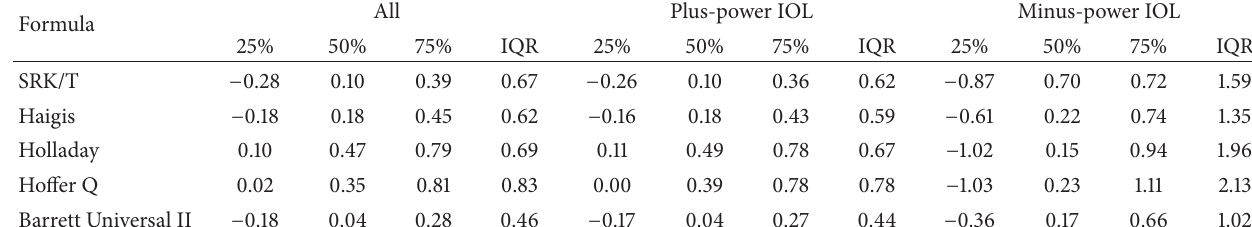
Table 4: Percentile rank of the numerical predicted error.